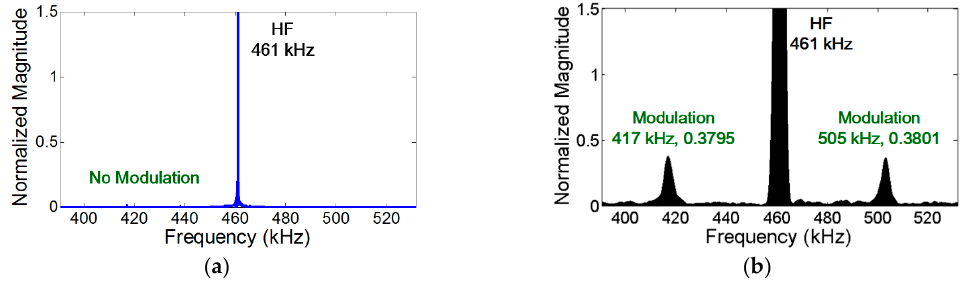
Figure 6. Experimental comparison of the effects of propagating wave and stationary vibration on modulation by converting HF input from a stationary sinusoidal input to a transient wave form. The modulation does not occur when the crack is located at the node of HF vibration mode. However, when the sinusoidal HF input is converted to a transient wave form, the modulation appears. Here, both 44 kHz LF and 461 kHz HF modes are S 0 modes, and the synchronism condition is avoided to minimize the effect of distributed material nonlinearity. ( a ) Crack is located at the anti-node of LF vibration mode and the node of HF mode; ( b ) HF input is converted from a stationary sinusoidal input in (a) to a transient wave.